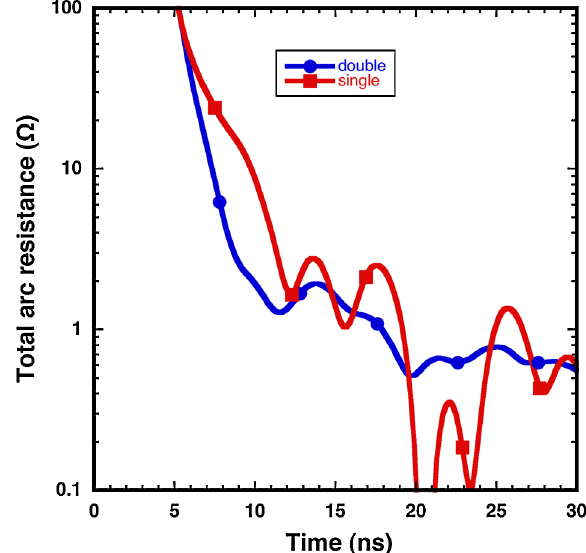
FIG. 10. (Color) Ratio of the top channel resistance to the bottom channel resistance. The channels share current consis- tently. Calibration and spurious noise issues may affect the calculation to some extent; the inflection at 325 ns is largely due to numerical issues with currents close to zero.